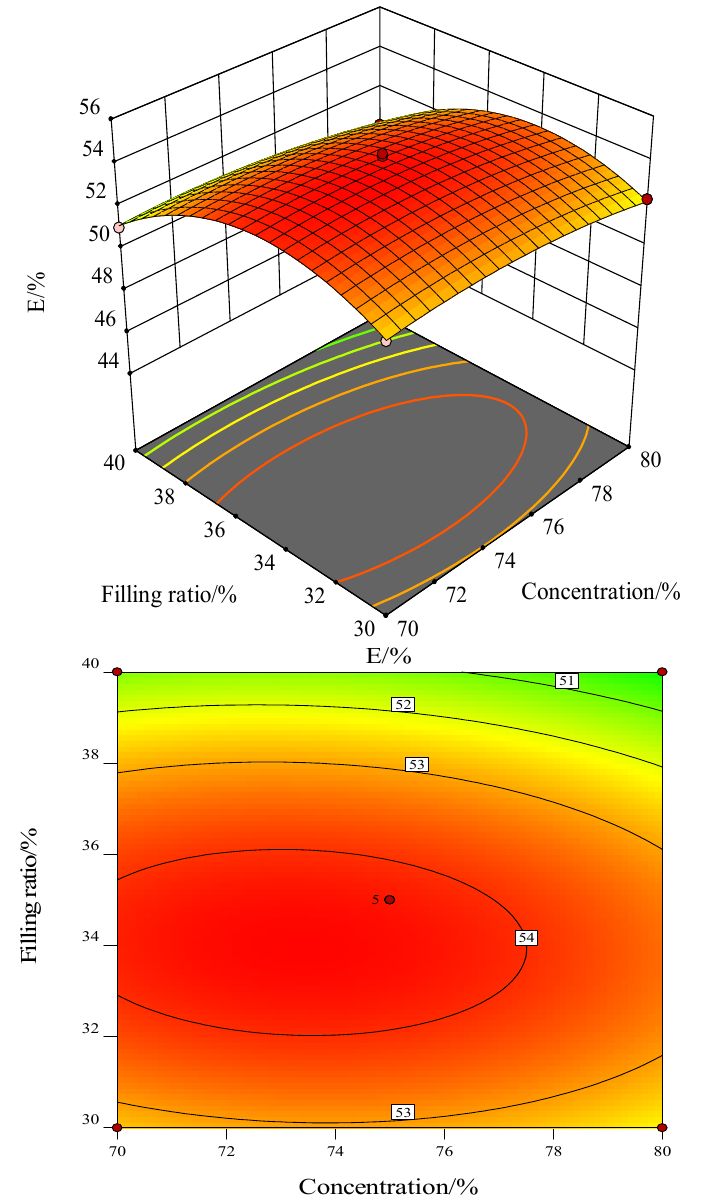
Figure 14. Response surface diagram and contour map at the action of grinding concentration and filling ratio. Table 19. Verification test